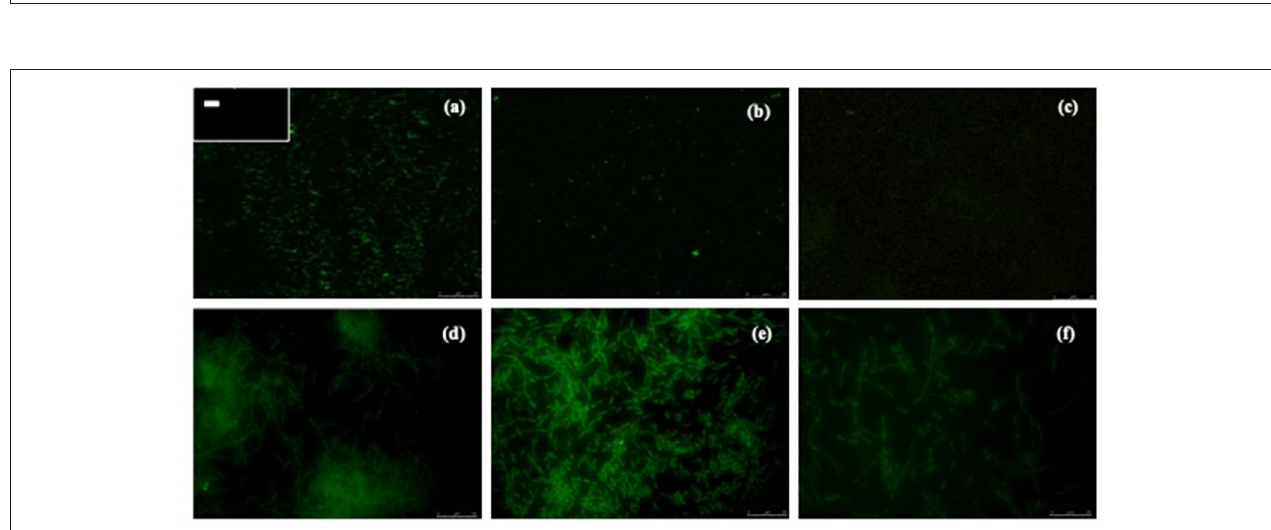
FIGURE 3 | Detection of A. pleuropneumoniae in biofilms produced from drinking water by fluorescent in situ hybridization. Micrographs were taken with confocal laser scanning microscopy (a–c) or epifluorescence microscopy (d–f) . (a) A. pleuropneumoniae 1-4074 and in the box at the upper left corner (–) negative control ( E. coli ATCC 25922). (b,c) A. pleuropneumoniae detection by CLSM. (d–f) A. pleuropneumoniae detection by EM (seen at 100 ×